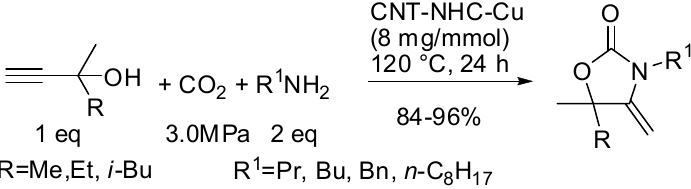
Scheme 20. Three-component coupling of CO 2 , primary amine, and various propargyl